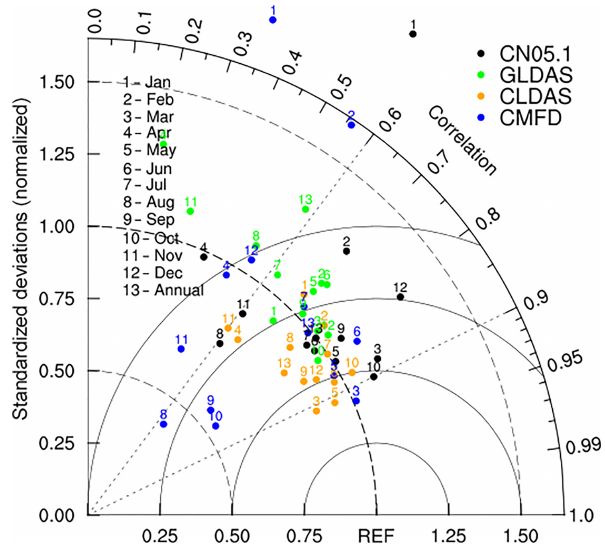
Figure 7. Taylor diagram summarizing the performance of monthly and annual mean precipitation from CN05.1 (black), CMFD (blue), CLDAS (orange) and GLDAS (green) relative to mutually indepen- dent rain gauge observations from MWR.